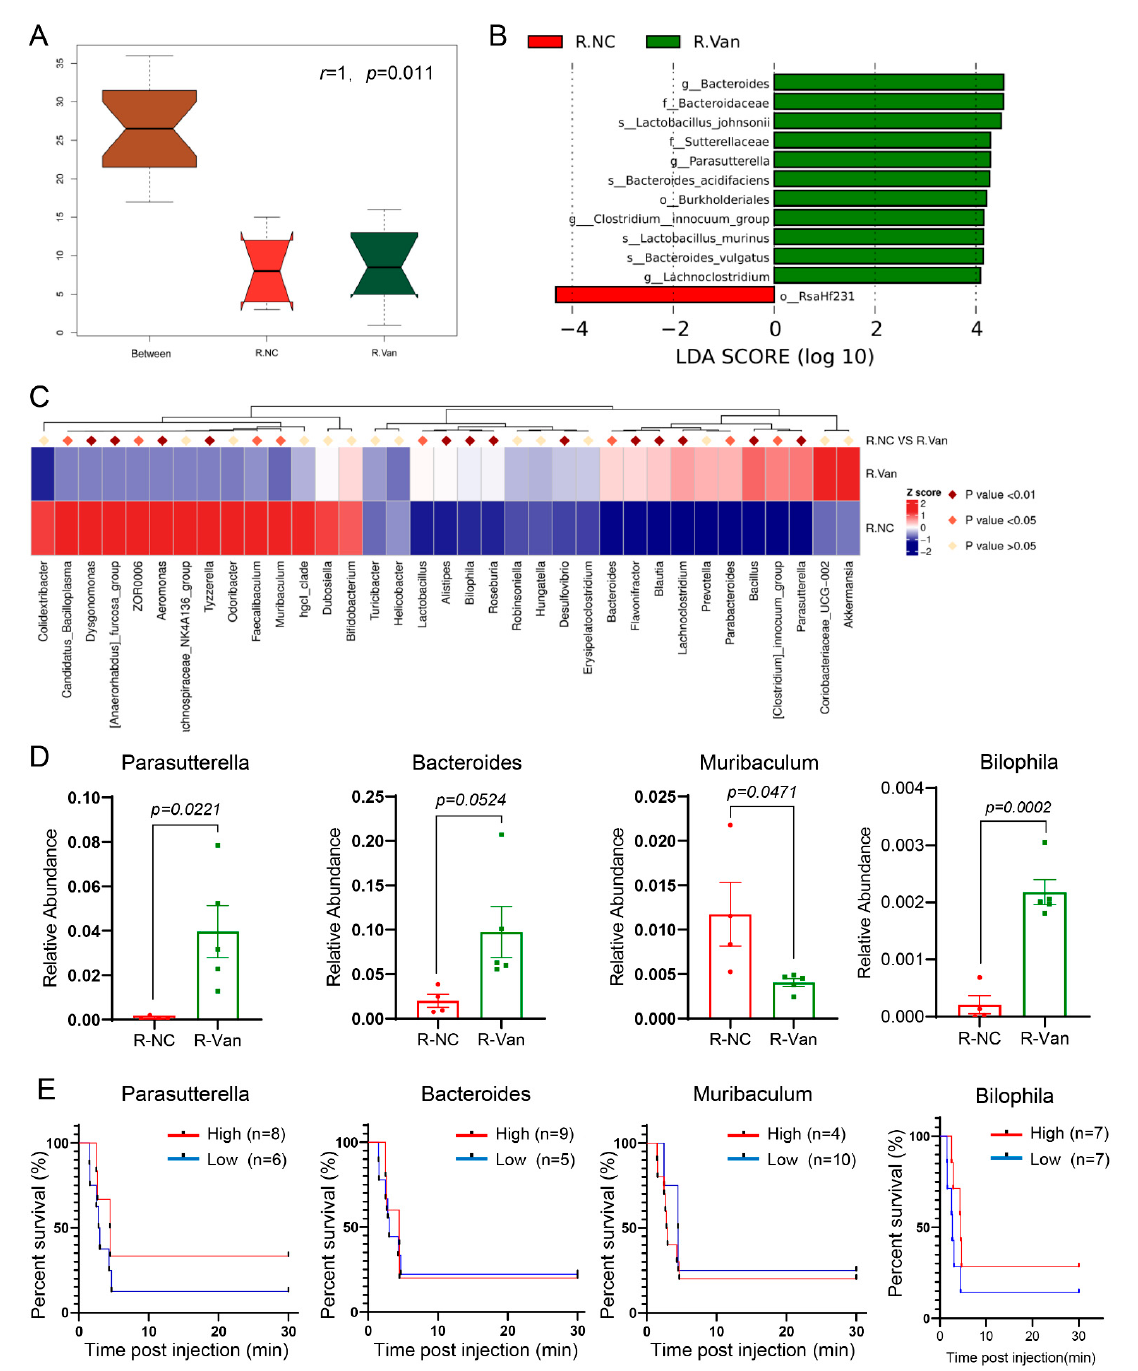
Figure 6. Vancomycin may inhibit pulmonary embolism by increasing Parasutterella. ( A ) Anosim of beta-diversity between R.NC and R.Van. ( B ) Results of LEfSe analysis showing bacterial taxa that were significantly different in abundance between R.NC and R.Van. The criteria for feature selection are LDA score (log10) > 4. p, phylum; c, class; o, order; f, family; g, genus. ( C ) Heatmap of selected most differentially abundant features at the genus level between R.NC and R.Van group. The blue color represents less abundant; white color represents intermediate abundance; and red represents the most abundant ( D ) Bar chart showing the relative abundance of gut microbes at genus level in R-NC and R-Van group. ( E ) Kaplan–Meier estimates for survival probability of APE mice based on the abundance levels of microbes. R-NC group, n = 4; R-Van group, n =